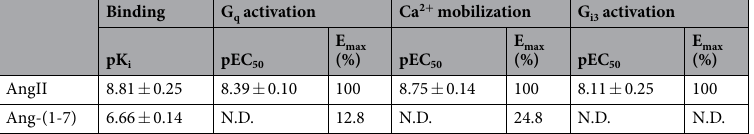
Table 1. Affinities of AngII and Ang-(1-7) for the AT 1 receptor from competition binding assays, and functional data presented as potencies (pEC 50 ) and efficacies (E max ) in promoting G protein- dependent signaling pathways. N.D.: Values could not be determined. EC 50 values are presented as mean ± SEM of at least three independent experiments. E max values for Ang-(1-7) are shown as a percentage of the maximum values obtained for